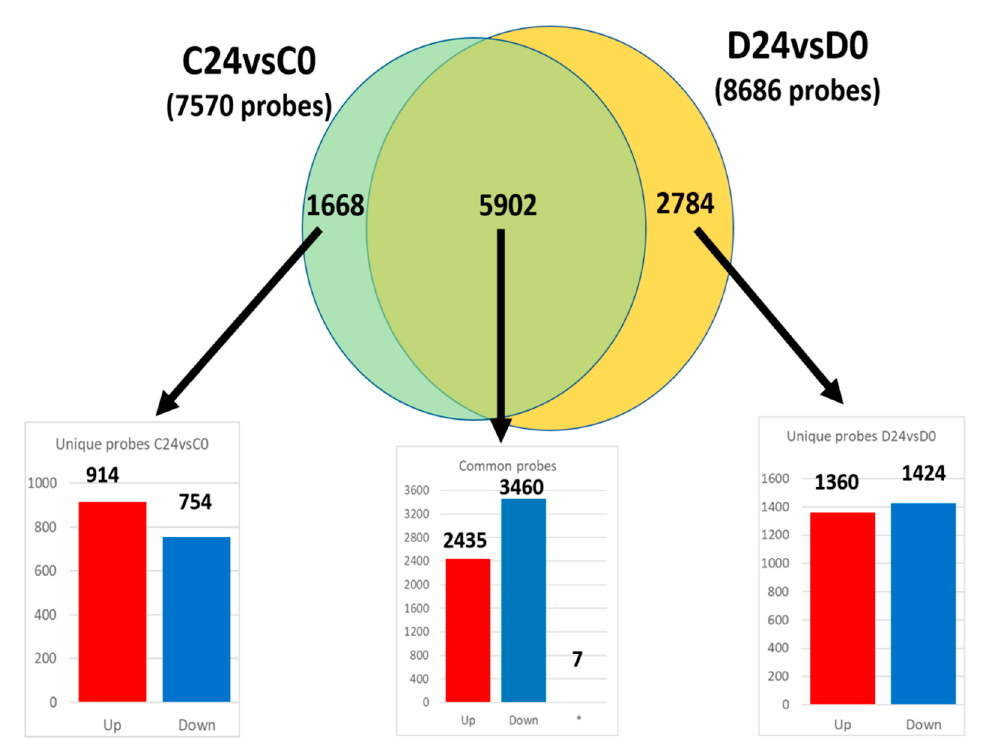
Figure 3. Venn diagram of common and unique differentially expressed probes in both wound healing processes (C24vsC0 and D24vsD0). The number in each bar graph indicates the up-(red) and down-regulated (blue) probes (FDR < 0.05). (*): Seven probesets out of the total 5902 common ones showed opposite regulation.